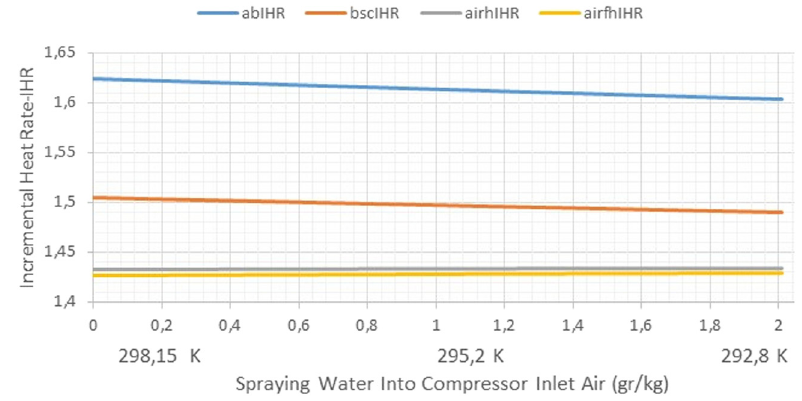
Figure 15: Variation of the IHR with spraying water into compressor inlet air ( g/kg ) for ab, bsc, airh, and airfh cogeneration